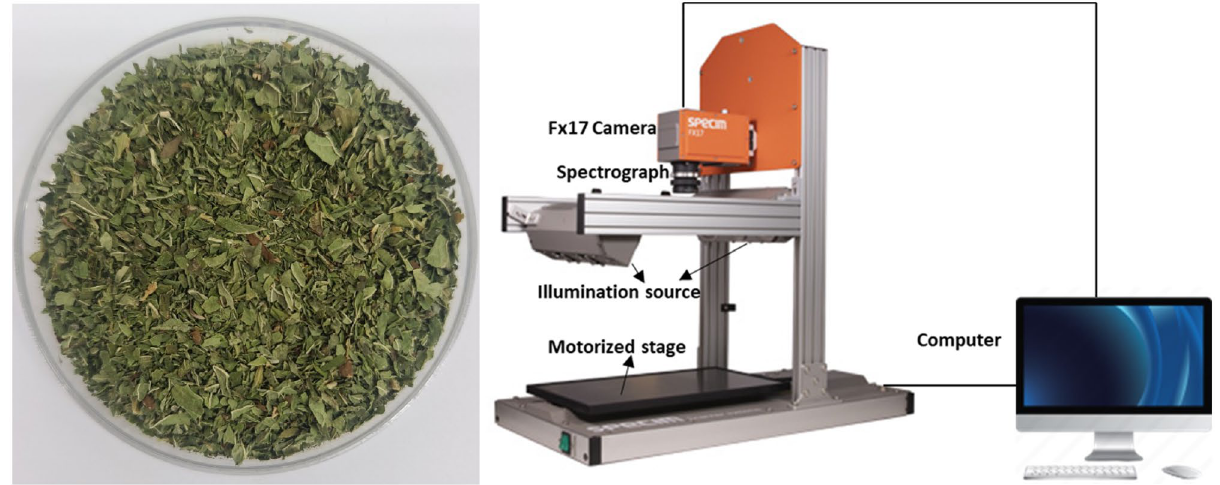
Figure 1. ( A ) Image of a dried spearmint sample. ( B ) Setup of the hyperspectral